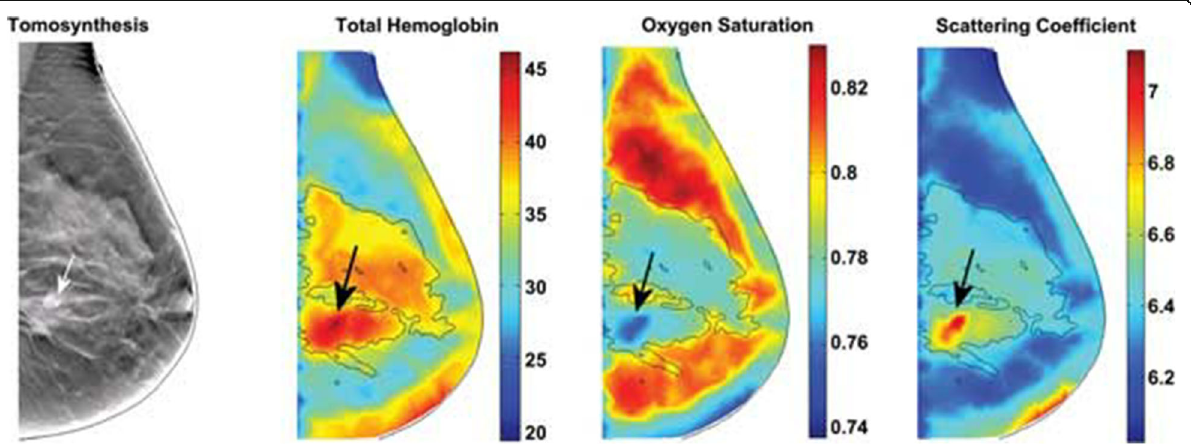
Fig. 23 Optical spectroscopy device probe for the measurement of breast blood factor concentrations [5]